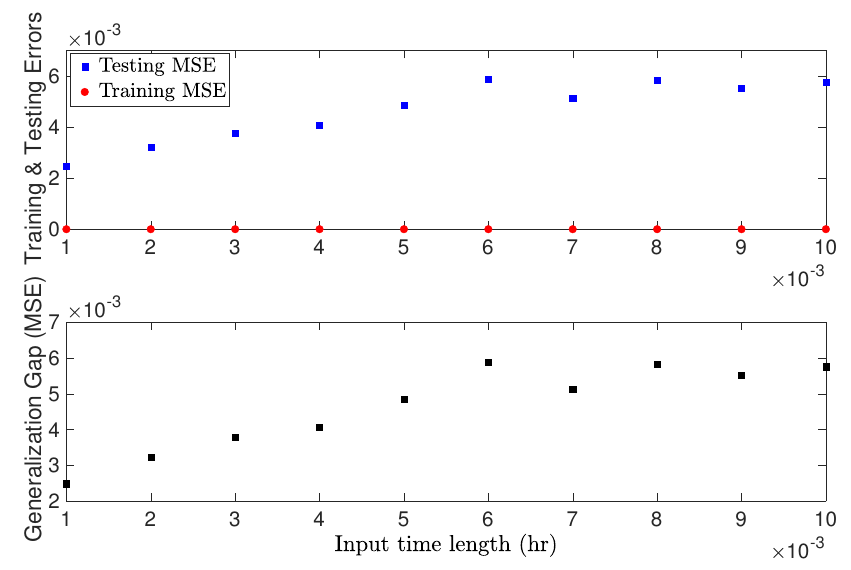
Figure 8. RNN generalization performance vs. input time